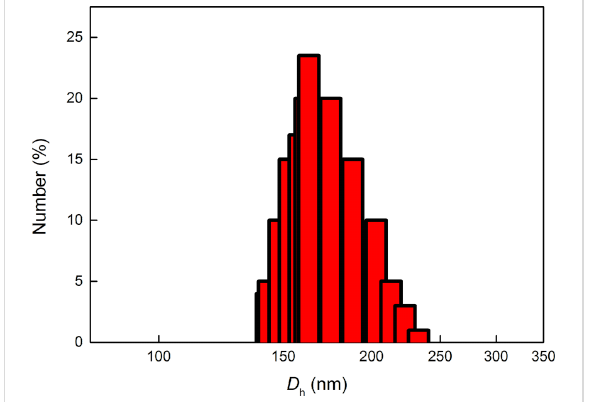
Figure 2: Particle size distribution of no. 4 OM-NaYF 4 :Yb 3+ /Er 3+ nanoparticles (Table 1) determined by DLS.